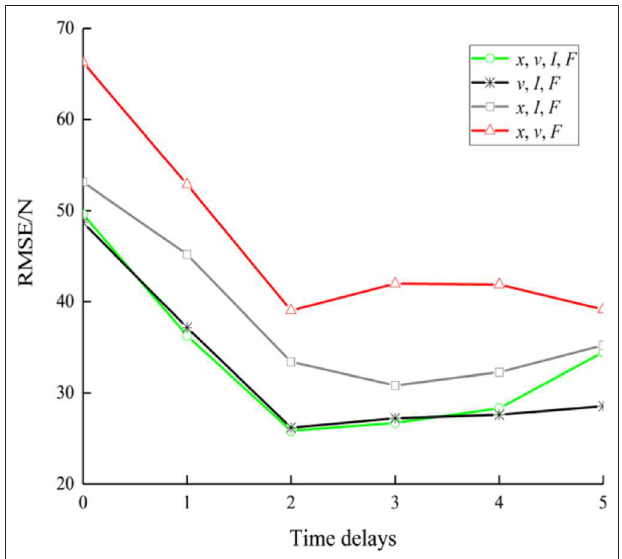
FIGURE 5 | The root mean square error (RMSE) under different hidden layer